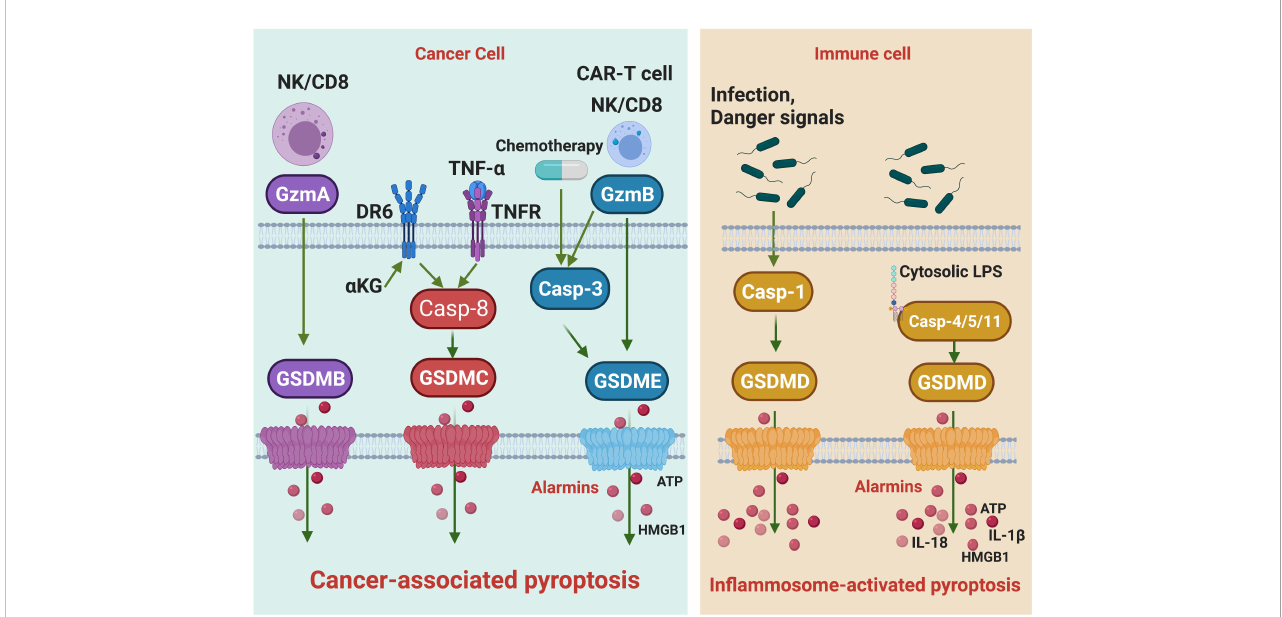
FIGURE 1 The signaling pathways of cancer-associated pyroptosis and in fl ammasome-activated pyroptosis. Killer lymphocytes, including NK cells and CD8 T cells, can release Gzms to activate GSDMs and trigger cancer-associated pyroptosis. GzmB cuts GSDME and GzmA cleaves GSDMB. The GzmB-induced pyroptosis can be ampli fi ed by caspase-3. In addition, chemotherapy drugs activating caspase-3 can also trigger GSDME pyroptosis. TNF- a and a -KG activate caspase-8 to initiate GSDMC-mediated cancer-associated pyroptosis, respectively. Alarmins such as ATP and HMGB1 are released during cancer-associated pyroptosis. Upon infection or danger signal perception, the assembly of canonical in fl ammasome leads to caspase-1 activation, which processes GSDMD to trigger in fl ammasome-activated pyroptosis. In the non-canonical in fl ammasome pathway, caspase-1/4/5 act as cytosolic receptors for lipopolysaccharide, a conserved component of Gram-negative bacterial cell wall. Recognition of LPS will activate caspase-1/4/5 to cleave GSDMD, leading to in fl ammasome-activated pyroptosis. Cytokines such as IL18 and IL-1 b are released during in fl ammasome-activated